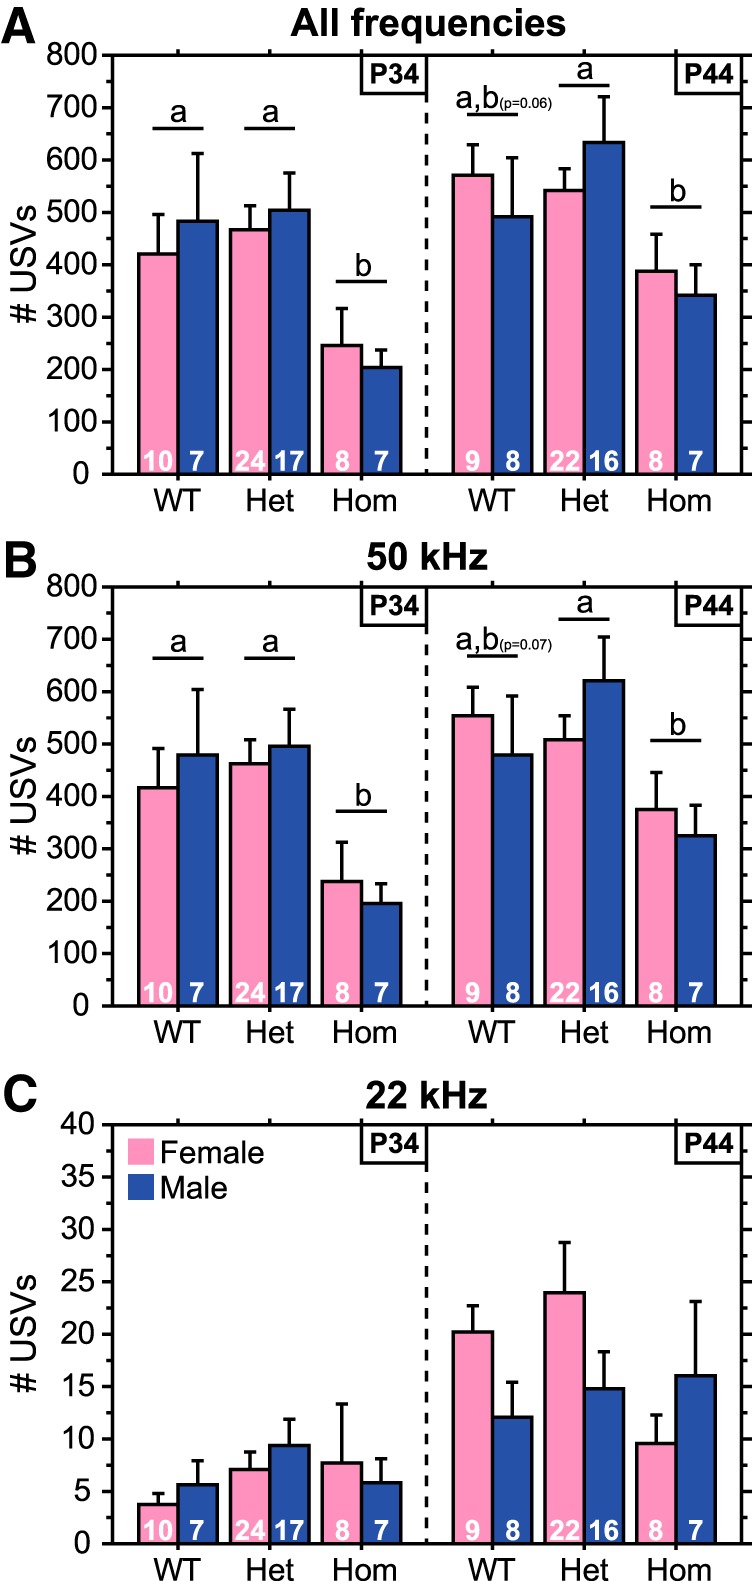
Hom Brattleboro juveniles emit fewer 50 kHz USVs. A–C, Number of all (A), 50 kHz (B), and 22 kHz (C) USVs of male and female Hom, Het, and WT rats during the first 10 min of a 20 min test at P34 or P44. Sample sizes are indicated within each bar. Data from each age were obtained from separate cohorts of animals. Genotypes with differing letters differ significantly from each other (p < 0.05, Fisher’s PLSD); where differences approach significance, the p value is included in parentheses next to the letter representing the appropriate comparison. See Results for ANOVA details.